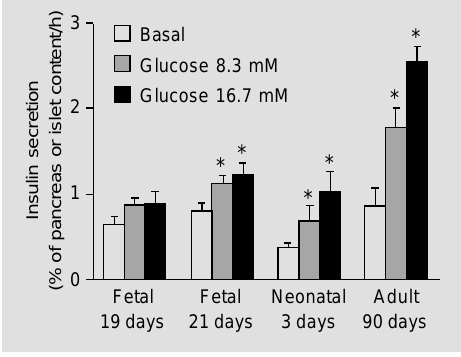
Figure 1 - Effect of 8.3 and 16.7 mM glucose on insulin secre- tion. Prior to exposure to differ- ent concentrations of glucose, fragments of fetal and neonatal pancreas or adult rat islets were preincubated for 45 min at 37 o C in a Krebs-bicarbonate medium containing 5.6 mM glucose. This preincubation medium was then replaced with Krebs-bicarbonate containing the desired concen- tration of glucose (8.3 or 16.7 mM). The columns represent the cumulative (1 h) insulin se- cretion, expressed as percent- age of the total fragment or islet content for each glucose con- centration. The values are re- ported as the mean ± SEM of 6- 25 experiments. *P<0.05 com- pared to basal insulin secretion.